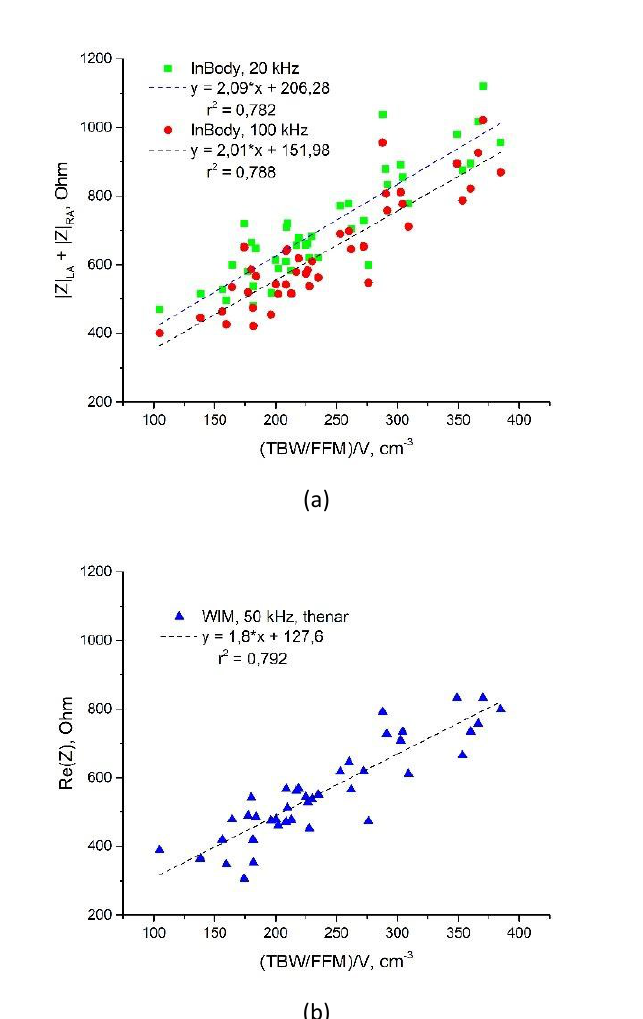
Fig.4: Arm volume multiplied by TBM/FFM ratio approximates bioimpedance: (a) Approximation of InBody 230 arm impedance. (b) Approximation of real part of bioimpedance measured with WIM.